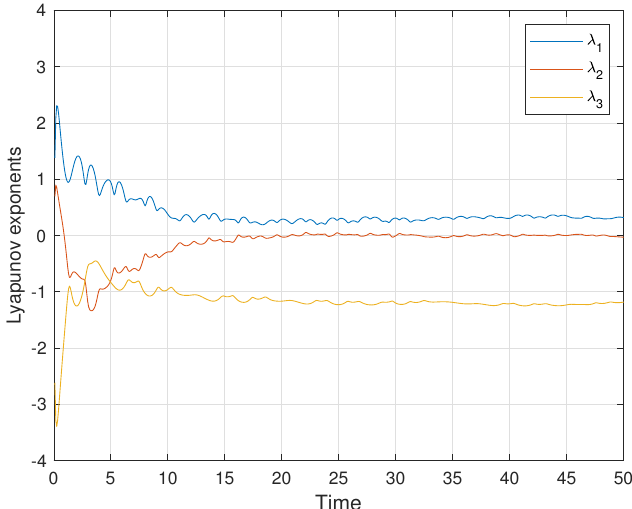
Figure 4. Maximum Lyapunov Exponent spectrum for the proposed discrete–time map based chaotic jerk system.